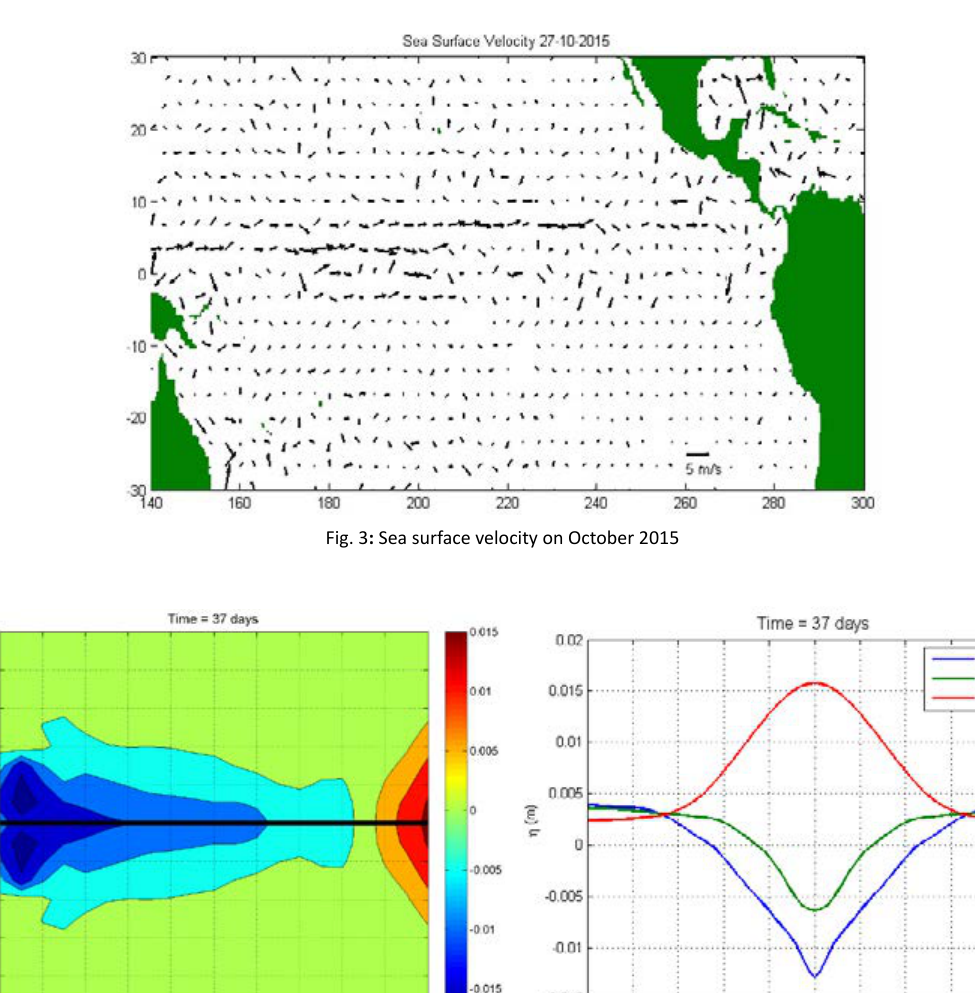
(b) Fig. 4: Sea level (a) plot on the 37th day of simulation, (b) value at the equator on the 37th day